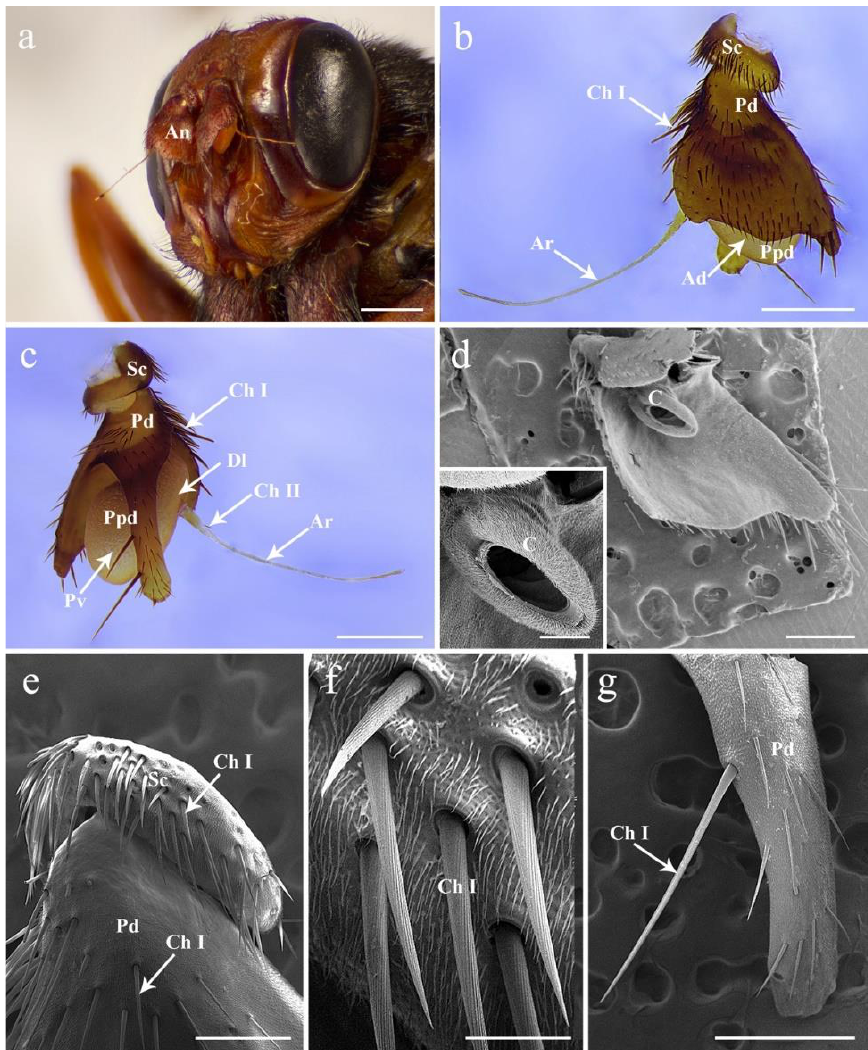
Figure 1. General morphology of antenna in female Gyrostigma rhinocerontis . ( a ) Antennae located centrally between compound eyes in resting position. ( b ) Anterodorsal surface of antenna. ( c ) Dorsolateral and posteroventral surface of antenna. ( d ) Details of antennal pedicel after removal of the postpedicel. ( e ) Anterodorsal surface of antennal scape showing the distribution of chaetic sensilla I. ( f ) Chaetic sensilla I on antennal scape showing the longitudinal grooves. ( g ) Ventral surface of the pedicel. Scale bars: ( a ) = 2 mm, ( b , c ) = 1 mm, ( d ) = 500 µ m, 15 µ m in inset, ( e ) = 250 µ m, ( f ) = 50 µ m, ( g ) = 500 µ m. Abbreviations: Ad, anterodorsal surface; An, antenna; Ar, arista; C, conus; Dl, dorsolateral surface; Ch I, chaetic sensillum I; Ch I, chaetic sensillum II; Pd, pedicel; Ppd, postpedicel; Pv, posteroventral surface; Sc,